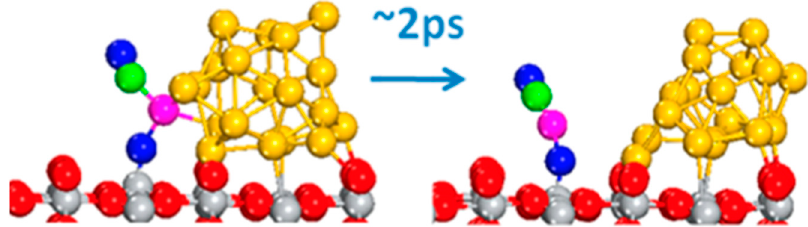
Figure 2. Initial ( left ) and successive ( right ) configurations sampled after 2ps during an AIMD simulation at 700 K comprising a supported Au nanocluster, one CO, and one Oad. Color coding: C: green, O: blue and red, Ti: gray, and Au: gold and pink. The pink Au atom labels the cation. Reprinted with permission from [69]. Copyright 2016 American Chemical Society.